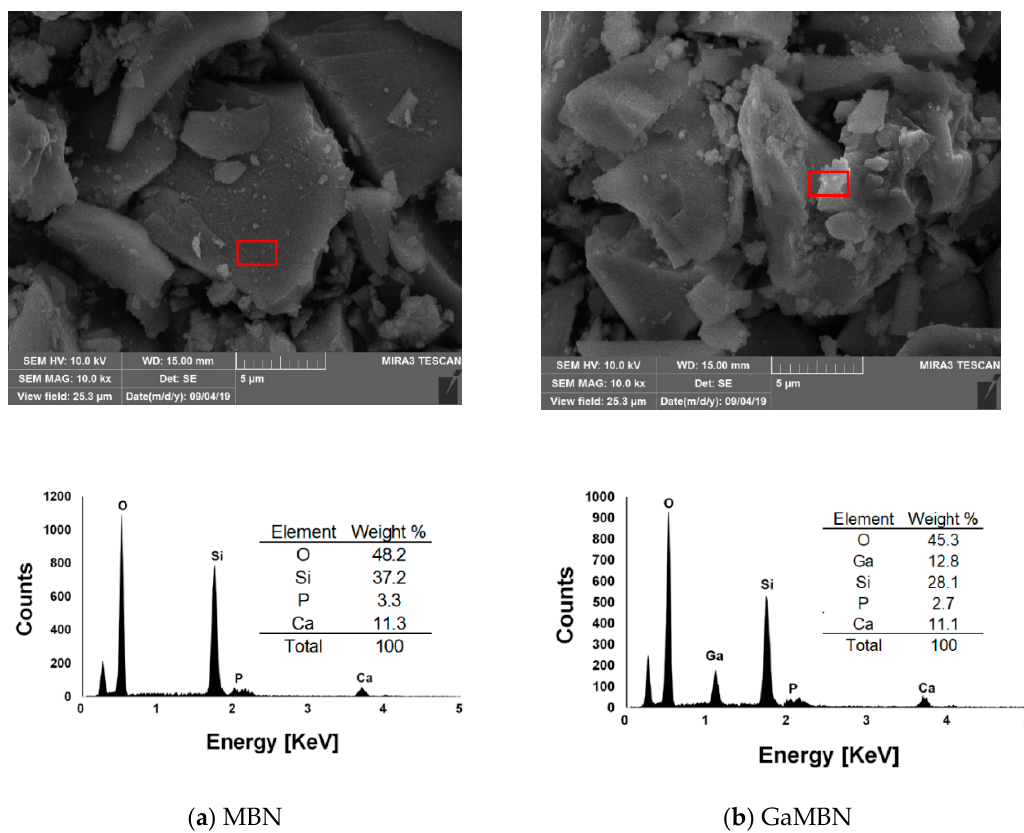
Figure 2. SEM images and EDX results of the ( a ) mesoporous bioactive glass nanoparticles (MBN) and ( b ) Ga-doped mesoporous bioactive glass nanoparticles (GaMBN). Red box indicates the region of interest.